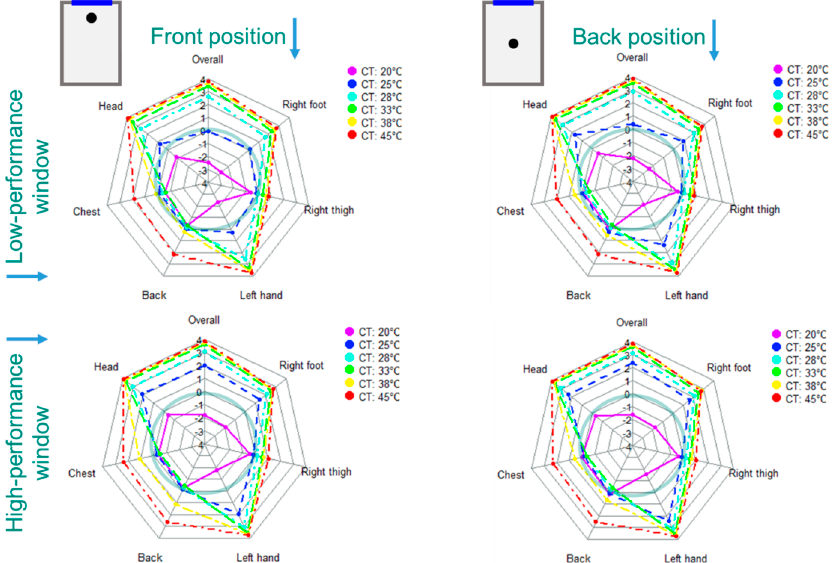
Figure 14. Overall and local thermal sensation at selected body limbs in the middle room with one façade influenced by ceiling temperatures, quality of facades, and the position of the manikin. Nine-point thermal sensation scale: “very cold, − 4”, “cold, − 3”, “cool, − 2”, “slightly cool, − 1” to “neutral, 0” then to “slightly warm, +1”, “warm, +2”, “hot, +3” and “very hot, +4”.